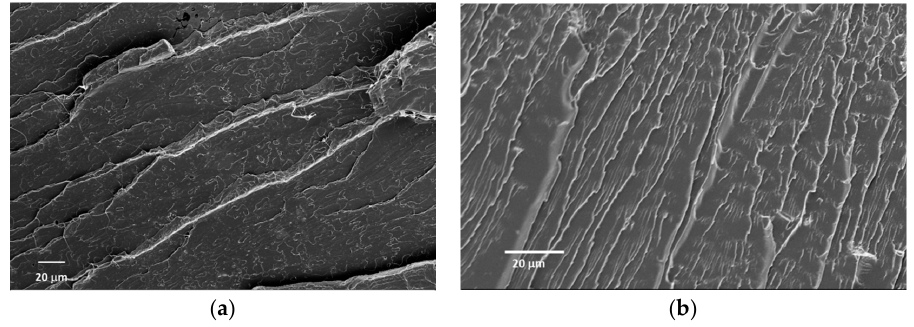
Figure 6. FE-SEM micrographs of cryogenically fractured surfaces of ( a ) neat PLA and ( b ) 1 wt % of F-CNC/PLA nanocomposites.